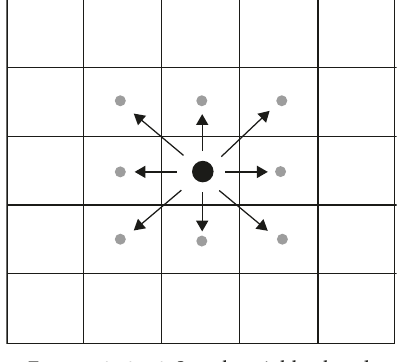
Figure 3: 3 ∗ 3 Search